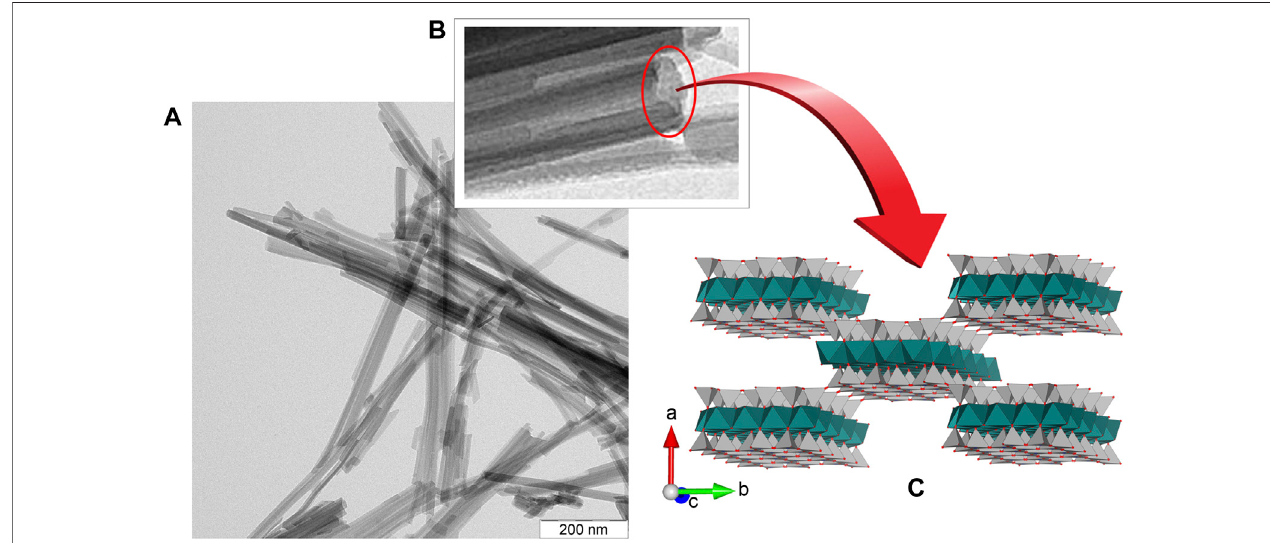
FIGURE 1 | Fibrous morphology (TEM image) of (A) a sepiolite sample from Tagus Basin, Spain, (B) detail of a slightly tilted fi ber, and (C) model of the crystal structure after Brauner and Preisinger (1956) represented with VESTA v3.1.8 software (Momma and Izumi, 2011).